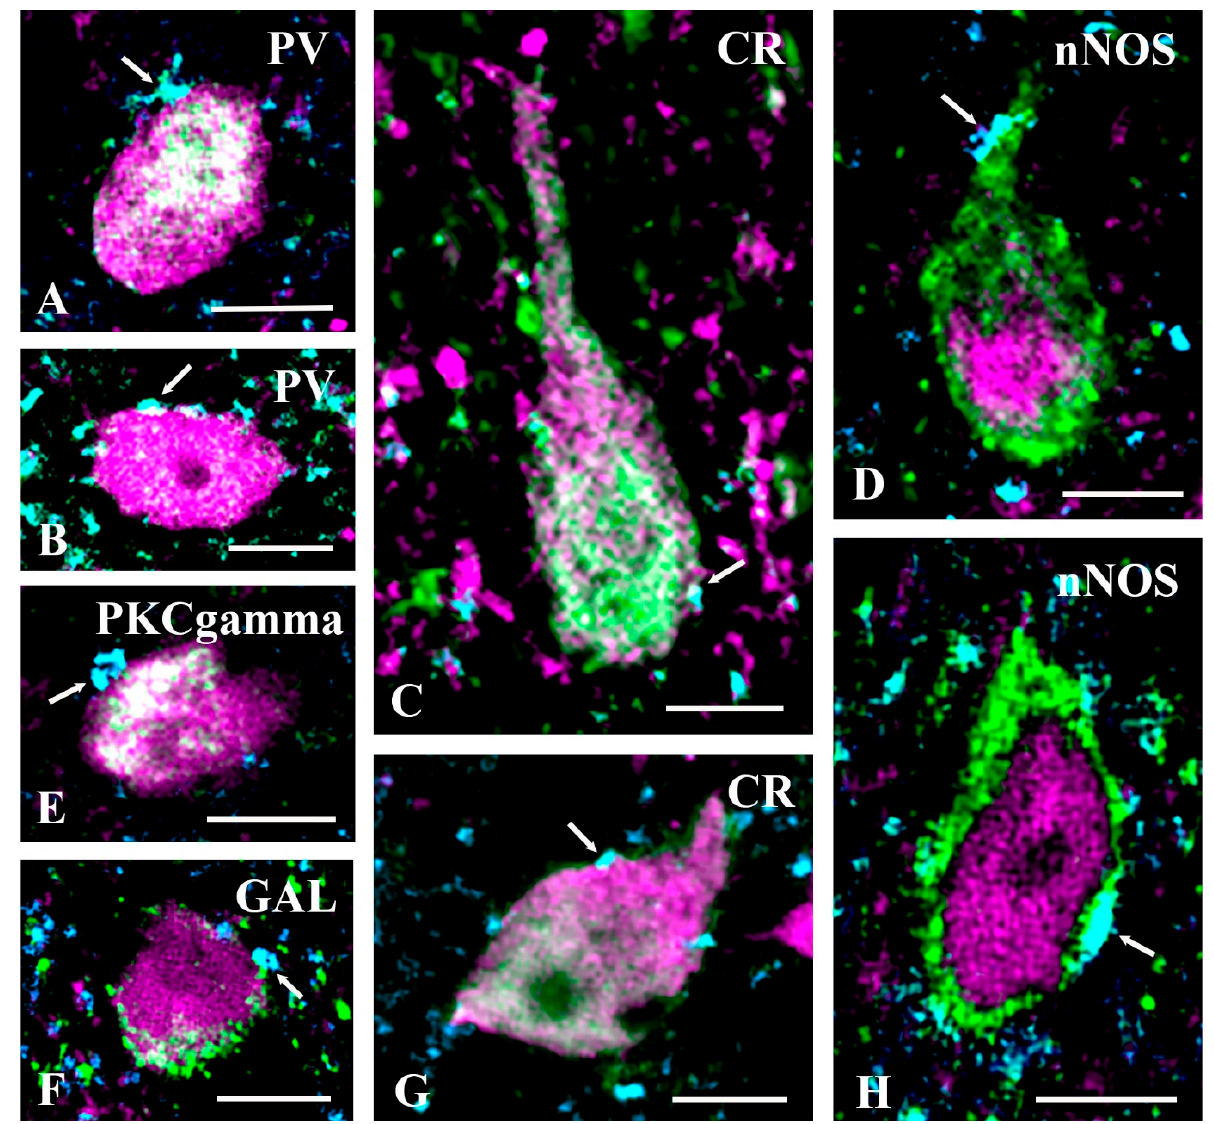
Figure 7. GlyT2 immunostained axon terminals make close appositions with inhibitory spinal interneurons. Close appositions between glycine transporter 2 (GlyT2) immunoreactive axon terminals (cyan) and the somata or proximal dendrites of parvalbumin (PV) ( A , B ), calretinin (CR) ( C , G ), neuronal nitric oxide synthase (nNOS) ( D , H ), protein kinase C gamma (PKCgamma) ( E ), and galanin (GAL) ( F ) (green) immunoreactive and PAX2Cre-tdTomato (magenta) positive inhibitory interneurons. Note the mixed colors of the cell bodies of the illustrated neurons. It is interesting to note that unlike in cells positive for the other neuronal markers, in the nNOS-positive neurons, nNOS immunostaining is restricted to the peripheral portion of the cytoplasm, whereas tdTomato can be observed in the central part of the cytoplasm. Arrows indicate GlyT2 immunostained axon terminals forming close appositions with the labeled neurons. Bars: 10 µm.